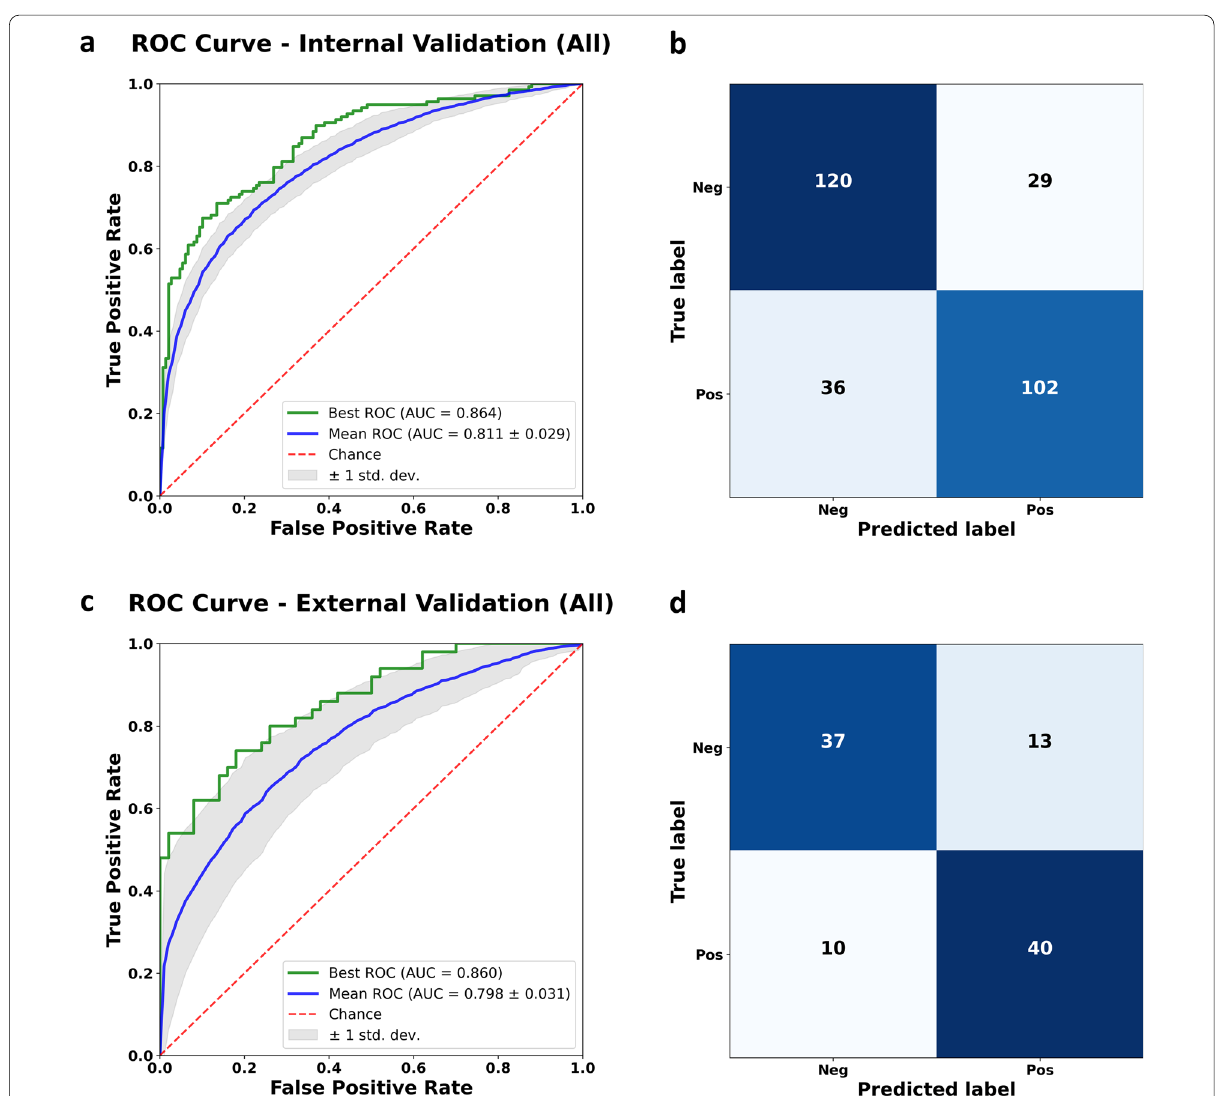
Fig. 4 ROC curve and confusion matrix of the best performing model for classifying Aβ PET positivity in the internal validation dataset ( a, b ) and the external validation dataset ( c, d ). Abbreviation: ROC